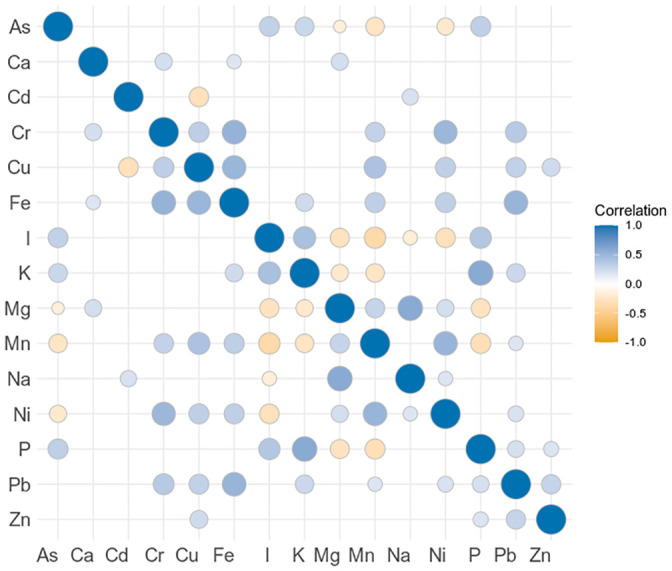
Matrix of element correlations for Greenland seaweeds, expressed as Kendall’s tau coefficient.Elements are ordered alphabetically for ease of reading. Hg and Se were excluded from the analysis due to the low number of quantifiable samples. Only statistically significant correlations (p < 0.05) are shown.